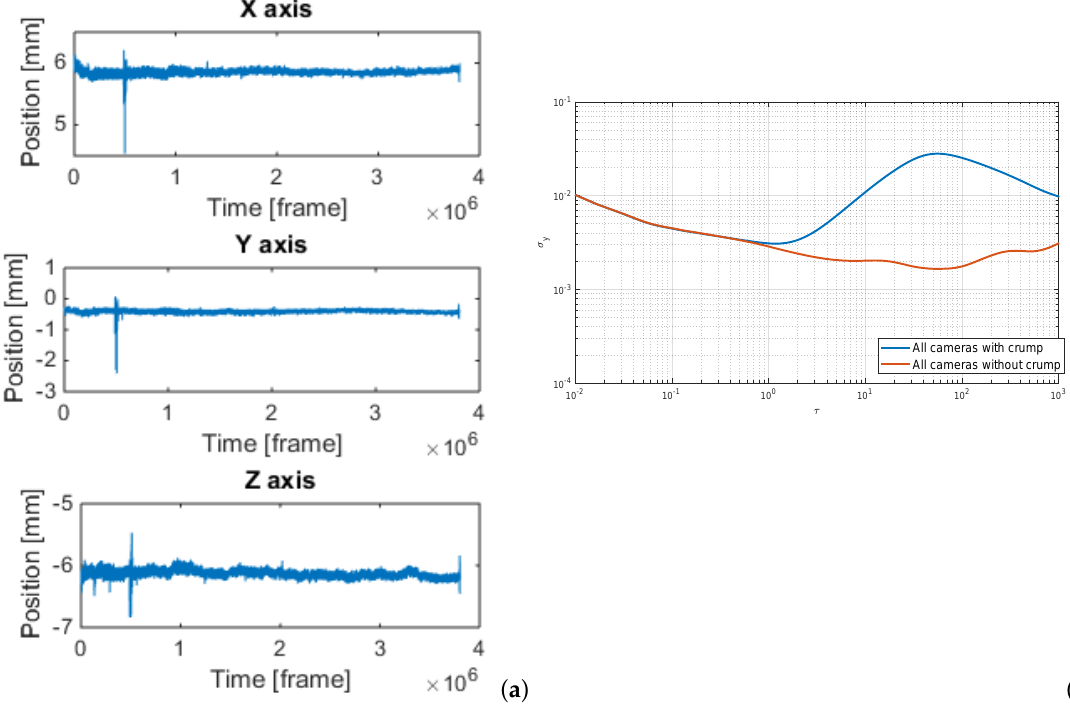
Figure 7. Position X,Y,Z of marker M1 based on data set 1 ( a ) with crump present, ( b ) ADEV of marker distance based on data with and without